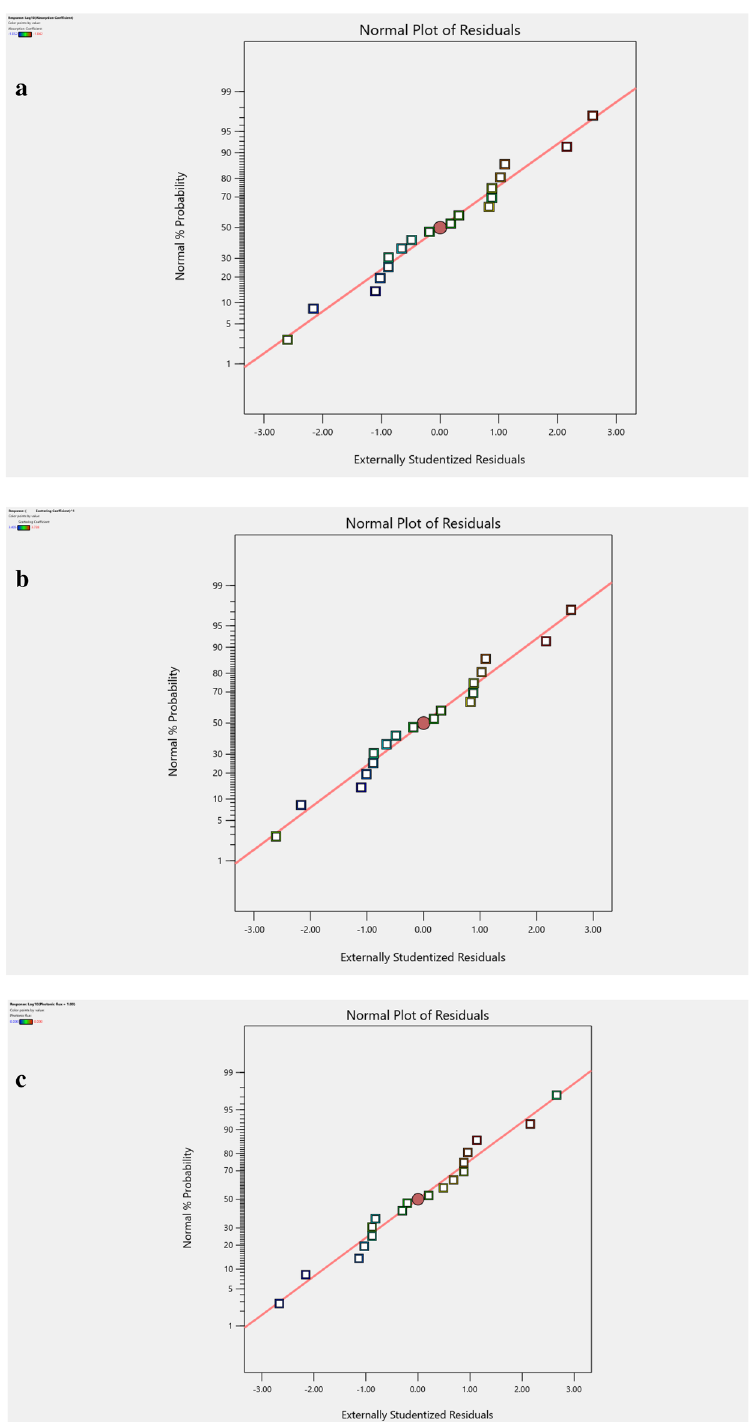
Figure 4. ( a ) The normal probability plot of residuals for mua—checks the mua data points are linear and follow the straight line (normal). ( b ) The Normal Probability plot of residuals for mus—checks the mus data points are linear and follow the straight line (normal). ( c ) The Normal Probability plot of residuals for phi— checks the phi data points are linear and follow the straight line